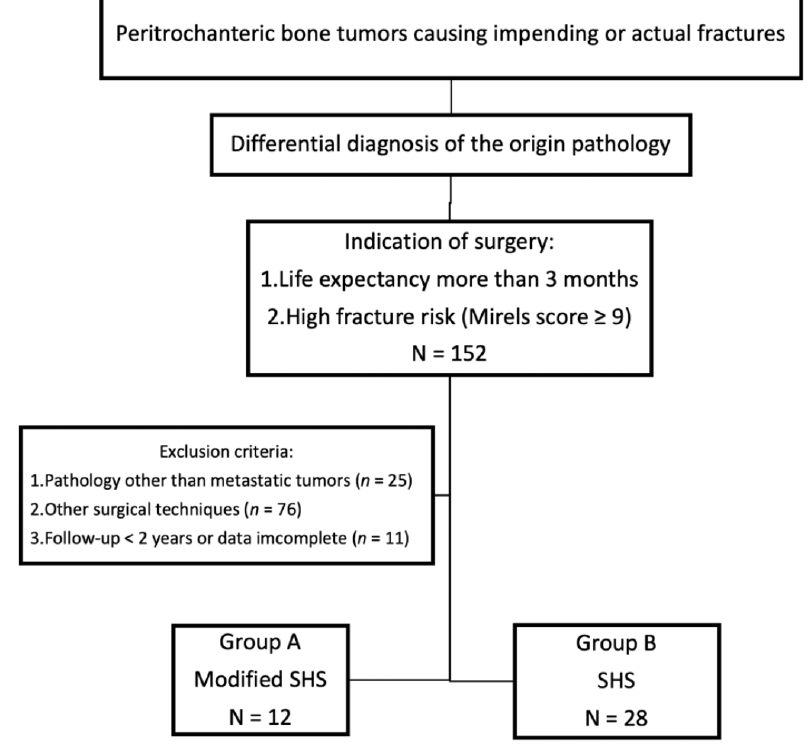
Figure 2. Flowchart of the